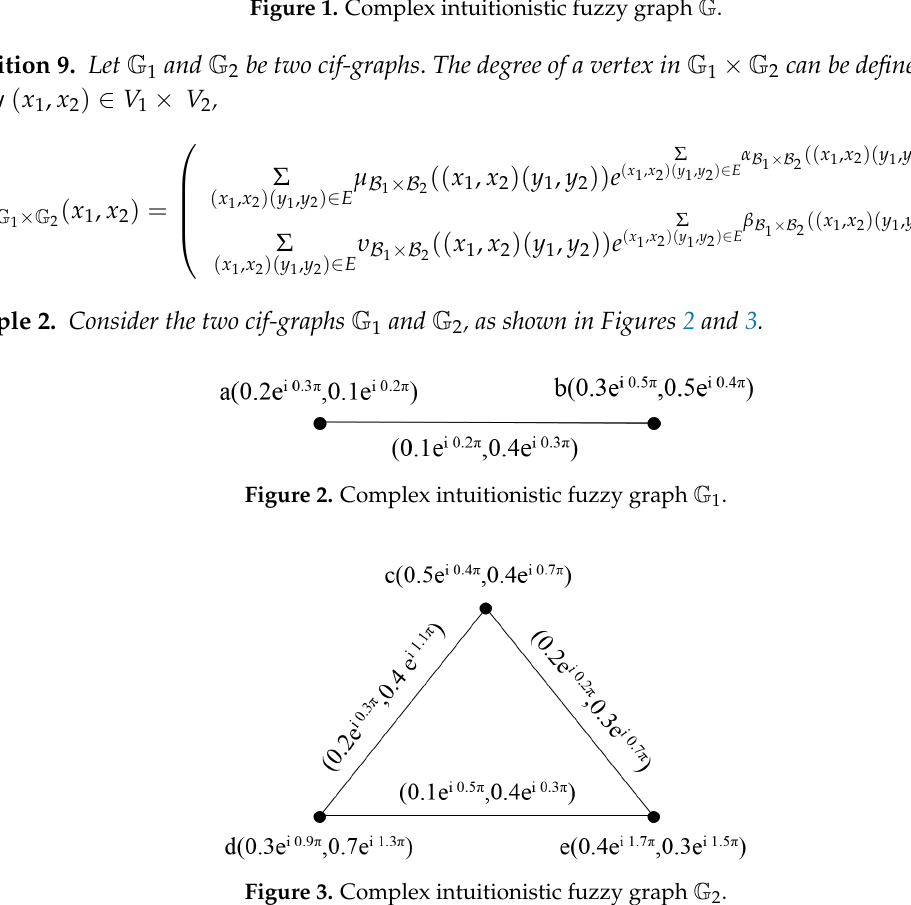
Figure 1. Complex intuitionistic fuzzy graph G .